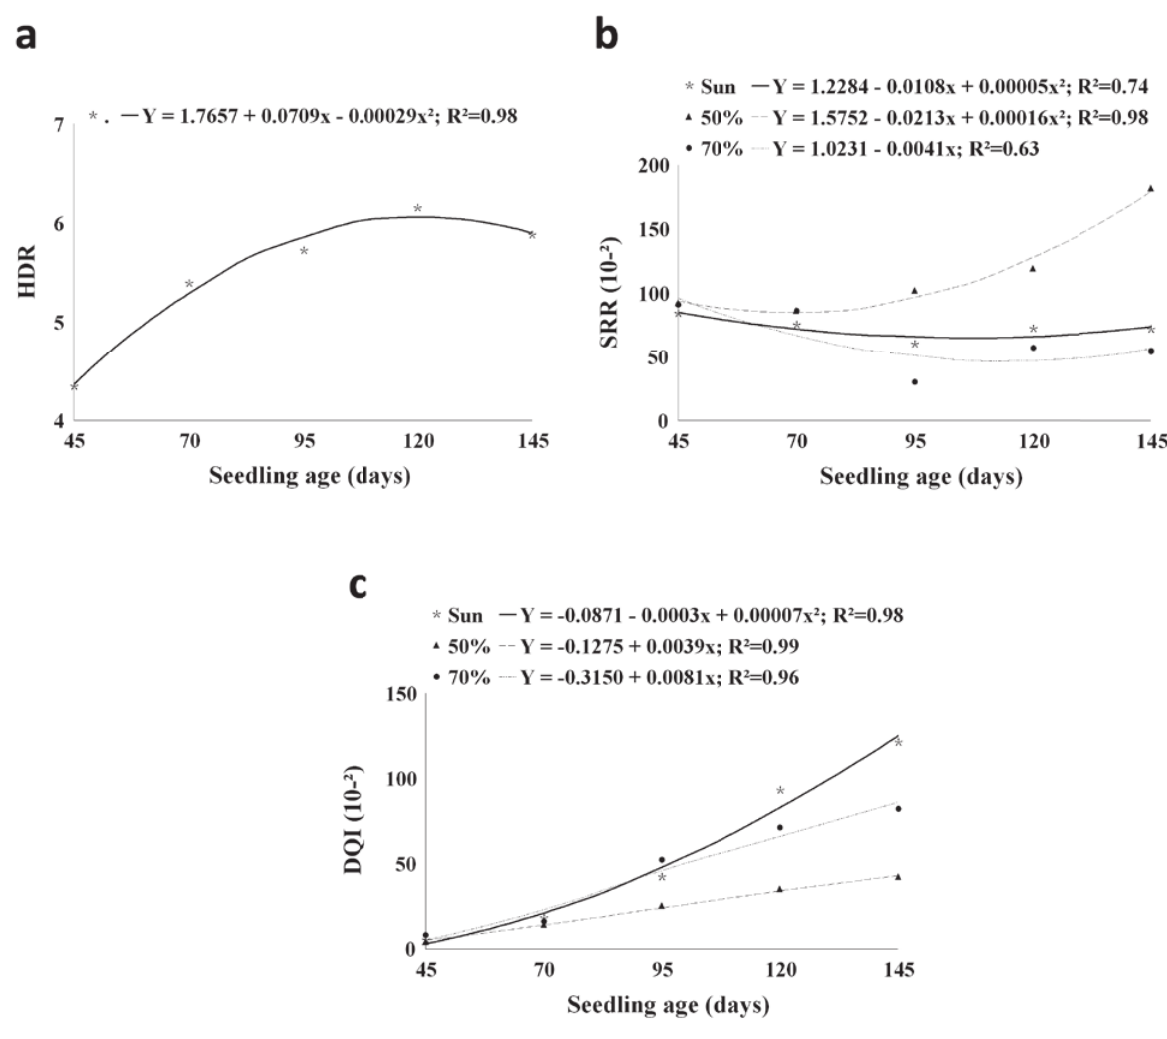
Figure 3 - HDR (a) , SRR (b) and DQI (c) of Myracrodruon urundeuva Allemão seedlings due to their age. HDR =